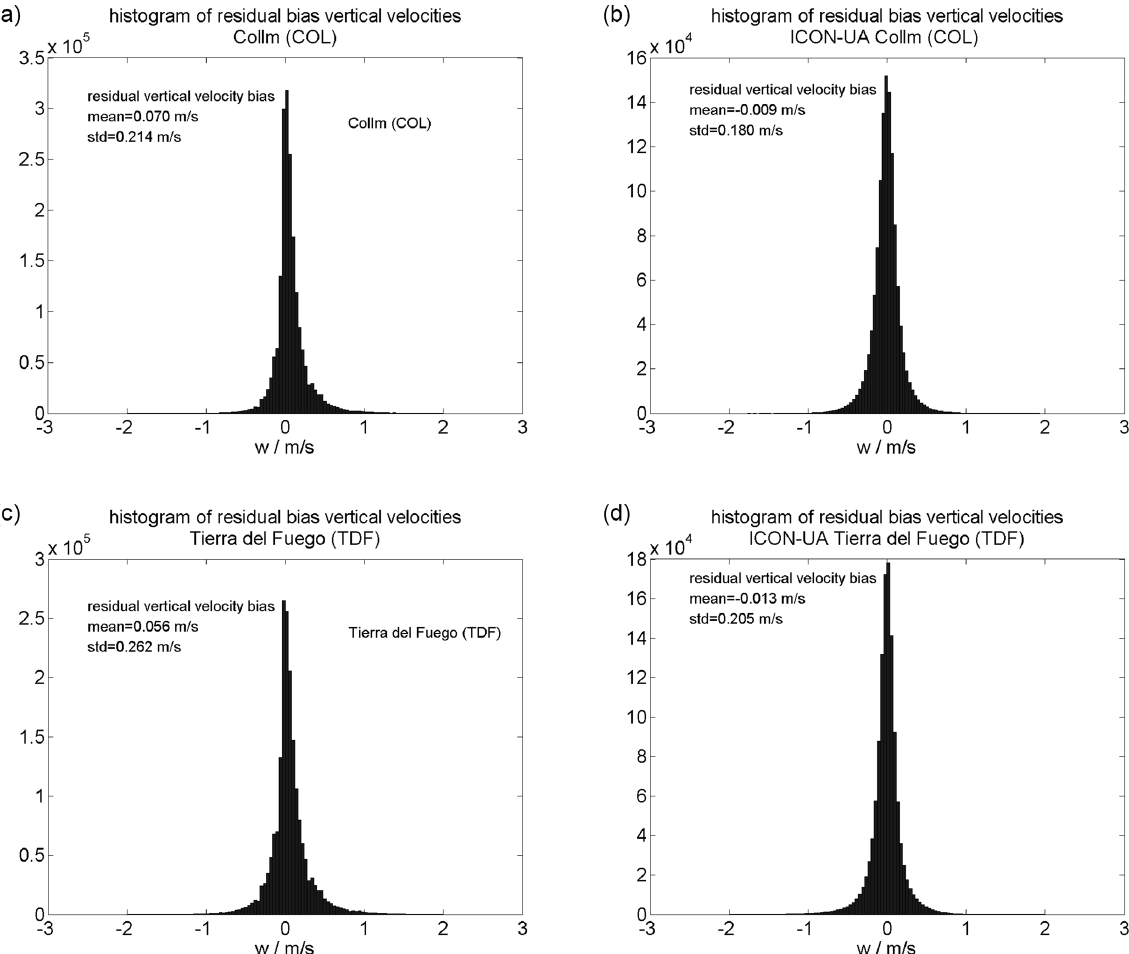
Figure 6. Histograms of the residual vertical velocity for the available data at COL and TDF including the debiasing from the spatiotemporal Laplace filter. The left panels (a,c) show the meteor radar observations. The right panels (b,d) visualize the corresponding UA-ICON velocities for a typical meteor radar sampling